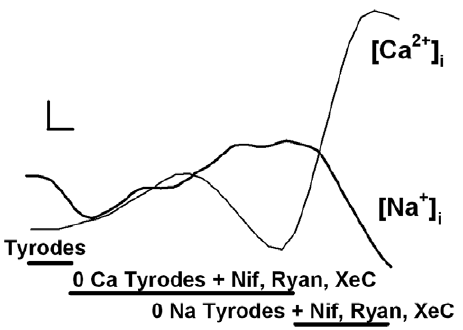
Figure 3. Evaluation of inward Ca 2 + exchange mode NCX in human ASM cells using measurement of [Ca 2 + ] i (fura-2) vs. [Na + ] i (SBFI). Removal of extracellular Ca 2 + in the presence of ryanodine (to inhibit SR Ca 2 + release via ryanodine receptor channels), Xestospongin C (to inhibit release via IP 3 receptor channels) and nifedipine (Nif; to inhibit L-type Ca 2 + channels) resulted in Na-loading of ASM cells (illustrated by increased [Na + ] i levels in SBFI loaded cells). Following Na-loading, rapid re-introduction of extracellular Ca 2 + and simultaneous removal of extracellular Na + resulted in activation of inward Ca 2 + exchange mode NCX, thus increasing [Ca 2 + ] i while decreasing [Na + ] i . Horizontal scale bar is 10 s. Vertical scale bar is 50 nM for Ca 2 + and 2 mM for Na + .